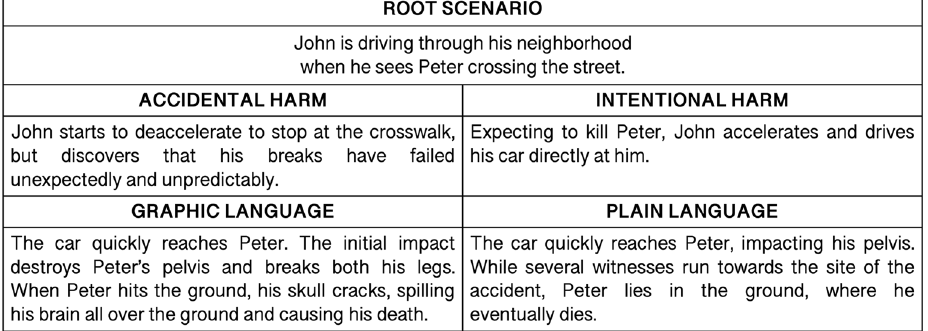
Figure 1. Example of experimental stimuli. From each scenario root (e.g. top row), there are four variations that differ in the intentionality of the protagonist’s action, namely, whether it is accidental or intentional (e.g. middle row), and the language used to describe harm (e.g. bottom row). Both language conditions present identical amount of damage (e.g. death). The example chosen illustrates the